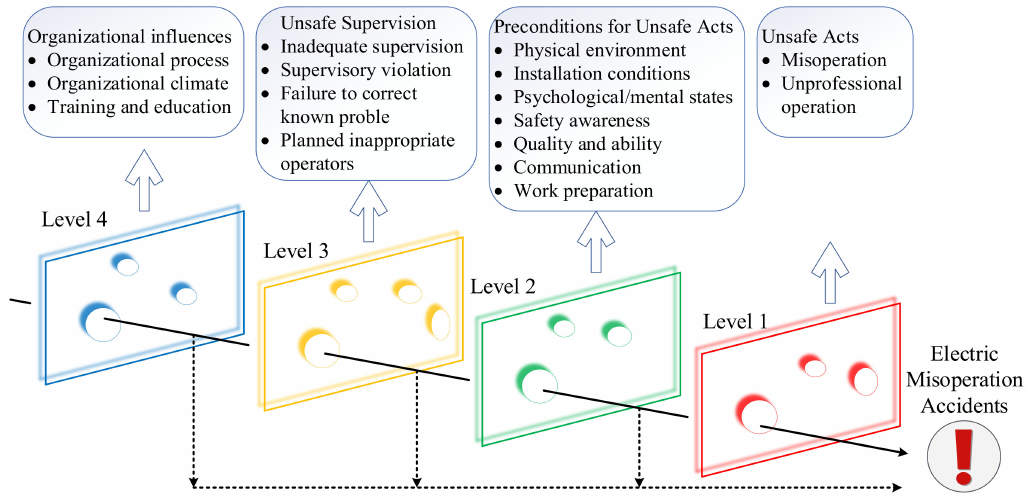
Figure 2. The HFACS